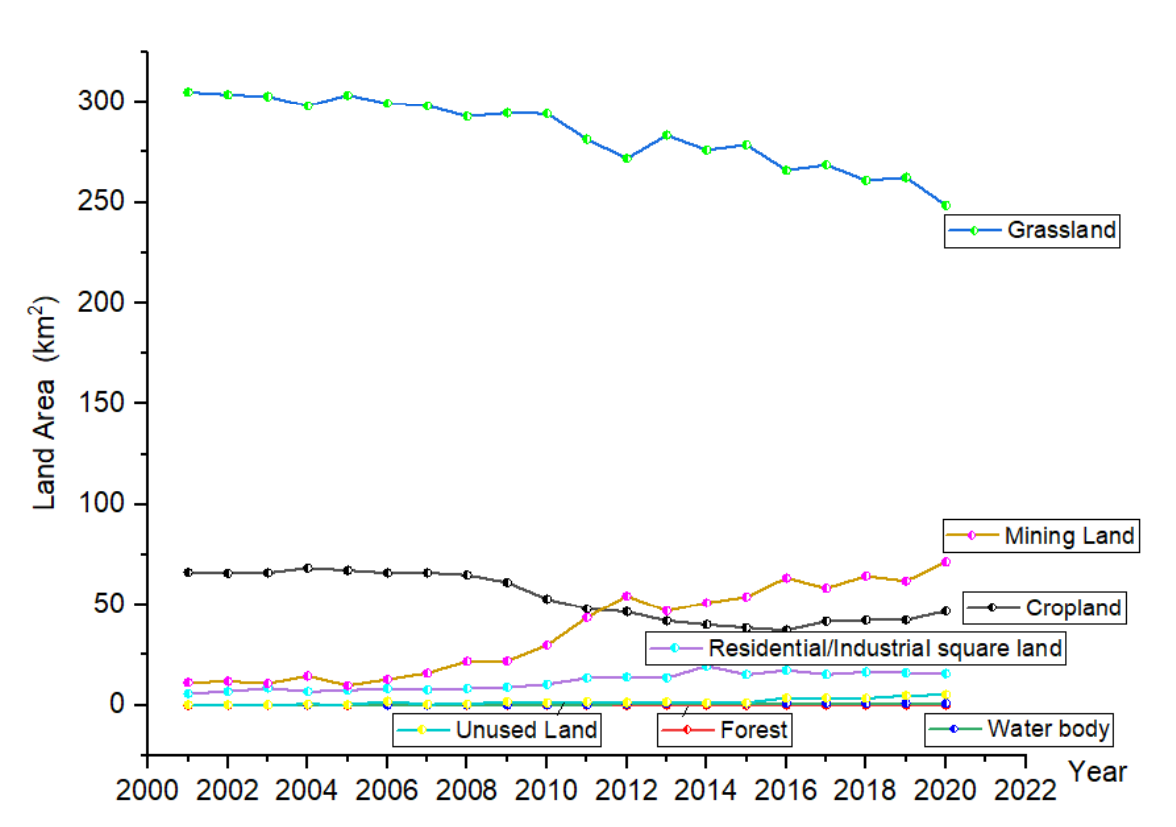
Figure 2. Land use types and areas in open-pit coal mines from 2001 – 2020.